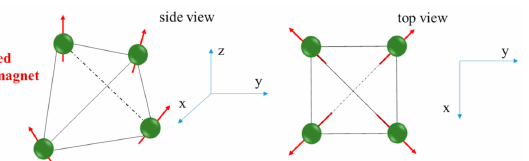
Figure 1. Schematic representation of the arrangement of spins of Yb 3+ ions in the crystal lattice of Yb 2 Ti 2 O 7 titanate with the pyrochlore